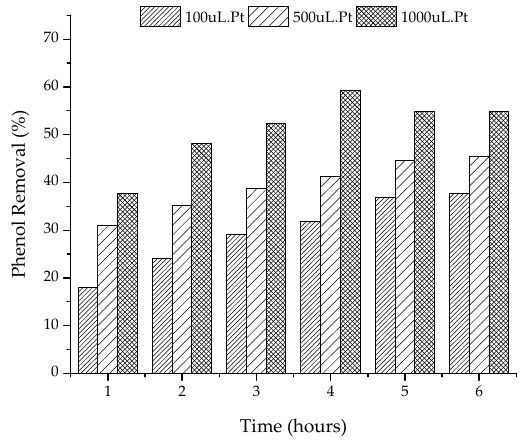
Figure 7. Kinetics of heterogeneous photocatalysis reaction in distilled water with 0.0125 g of catalyst, 1 to 6 h of UV light, an amount of platinum solution (100, 500, or 1000 µ L), and pH = 3.5.